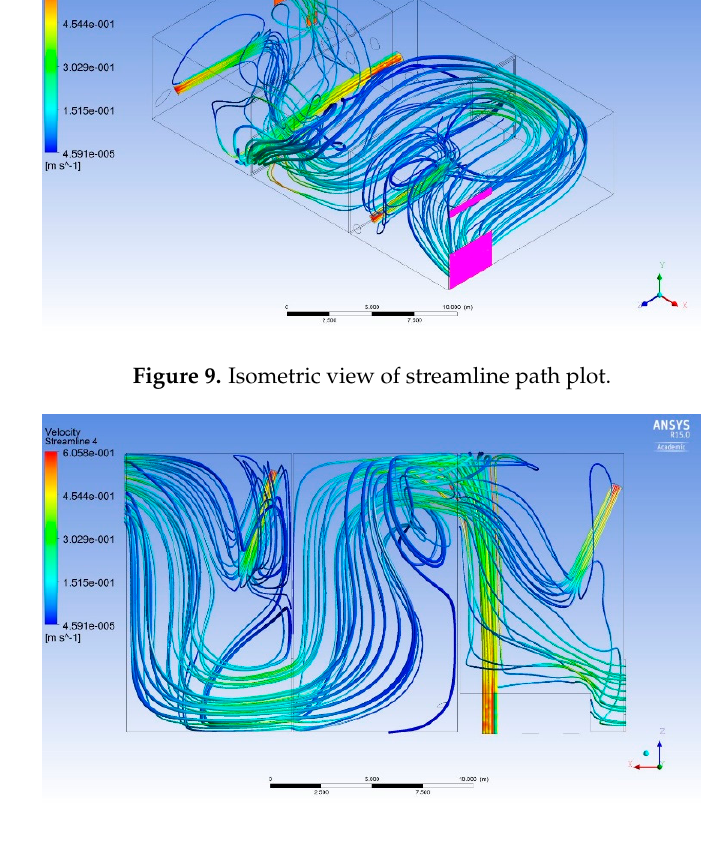
Figure 10. Top view of streamline path plot (current operation 15 min).